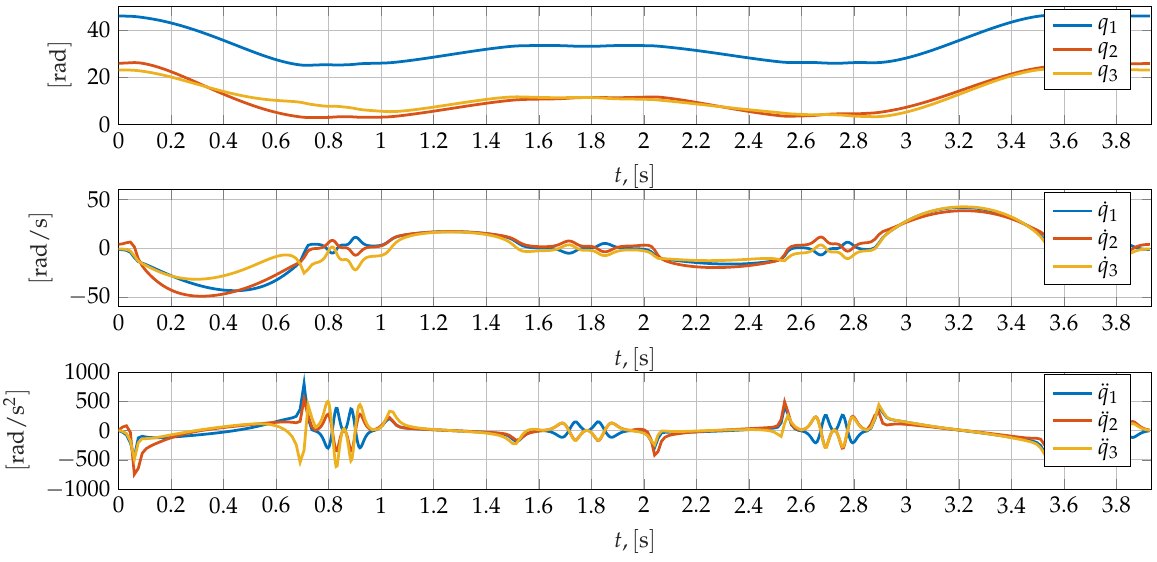
Figure 9. Position, velocity and acceleration components at the end effector.